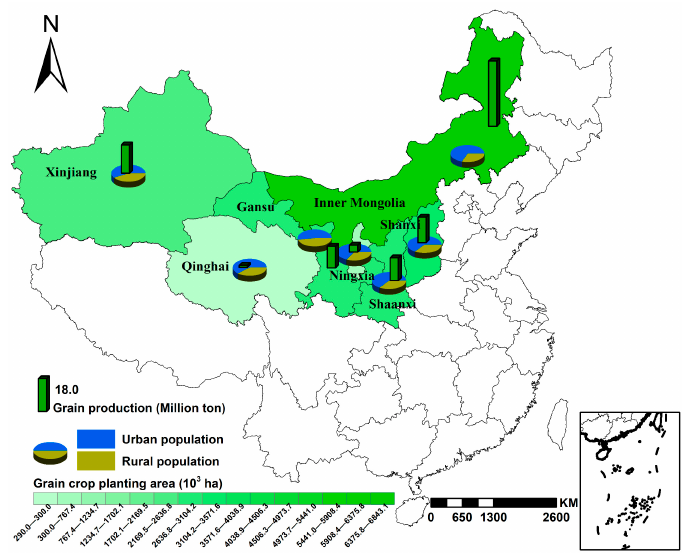
Figure 1. Survey of geography of Northwest China.